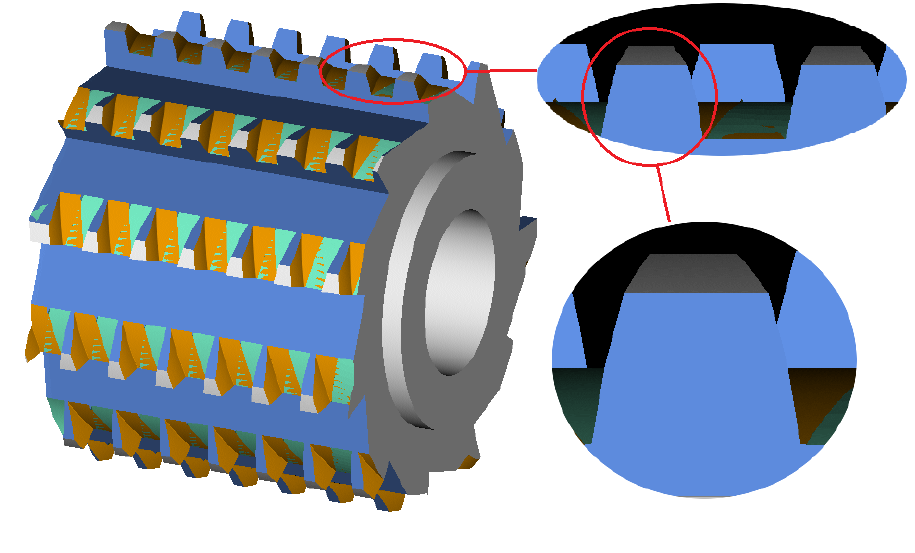
Figure 3. Technological 3D model of hob, designed with the principles of the relieving work (relieving work on cylinder not